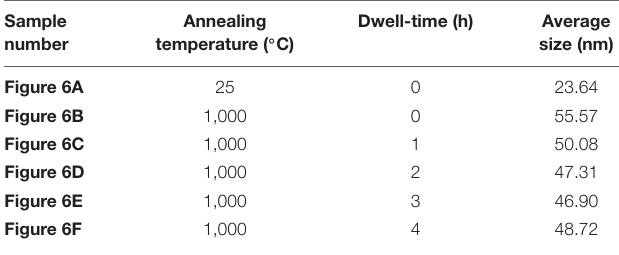
TABLE 2 | Statistical analysis of SEM